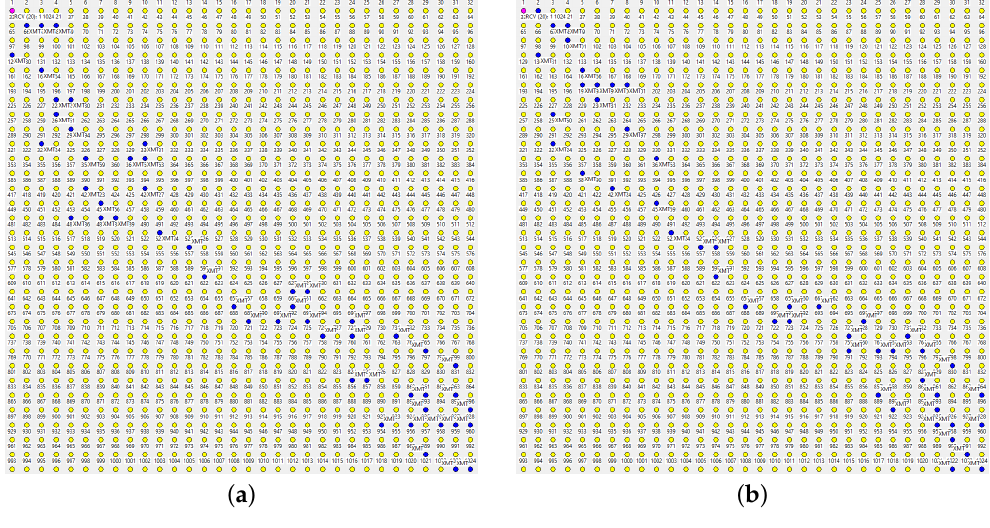
Figure 7. Two paths across the network. ( a ) Path 1; ( b ) path